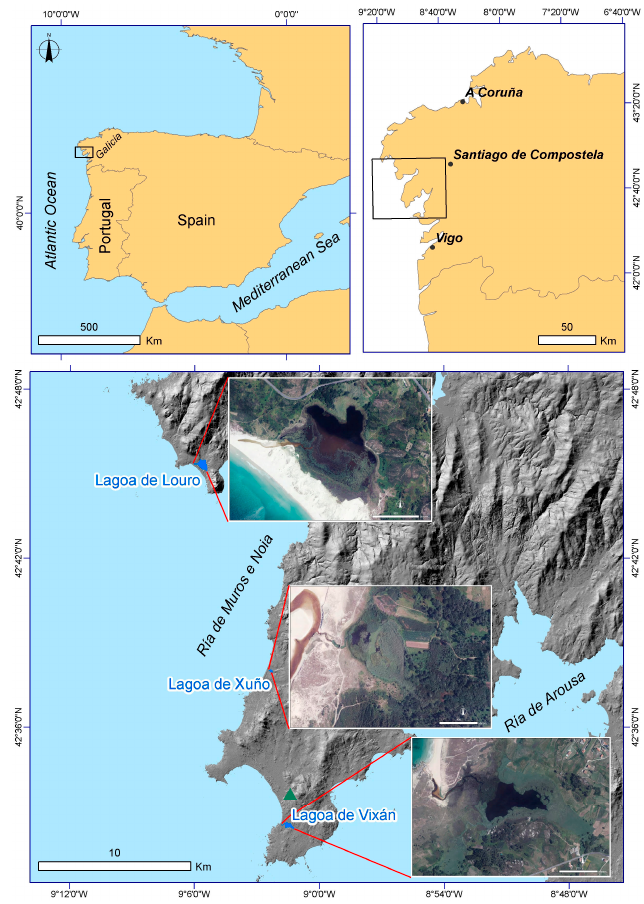
Figure 1. Study locations. The pictures show the three di ff erent lagoons: Louro, Xuño, and Vix á n. The green triangle indicates the location of the Riveira meteorological station (Figure